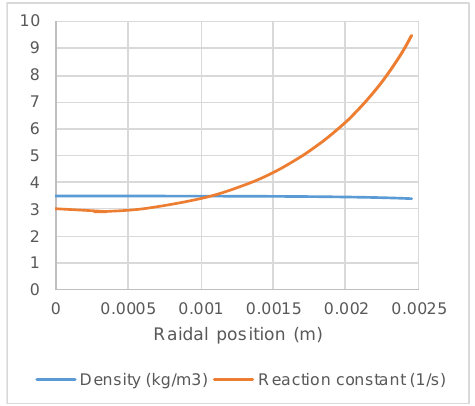
Figure 12. Radial profiles of gas density and the approximate reaction rate constant (Equation (A8)) in a particle close to the inlet of the simulated geometry.